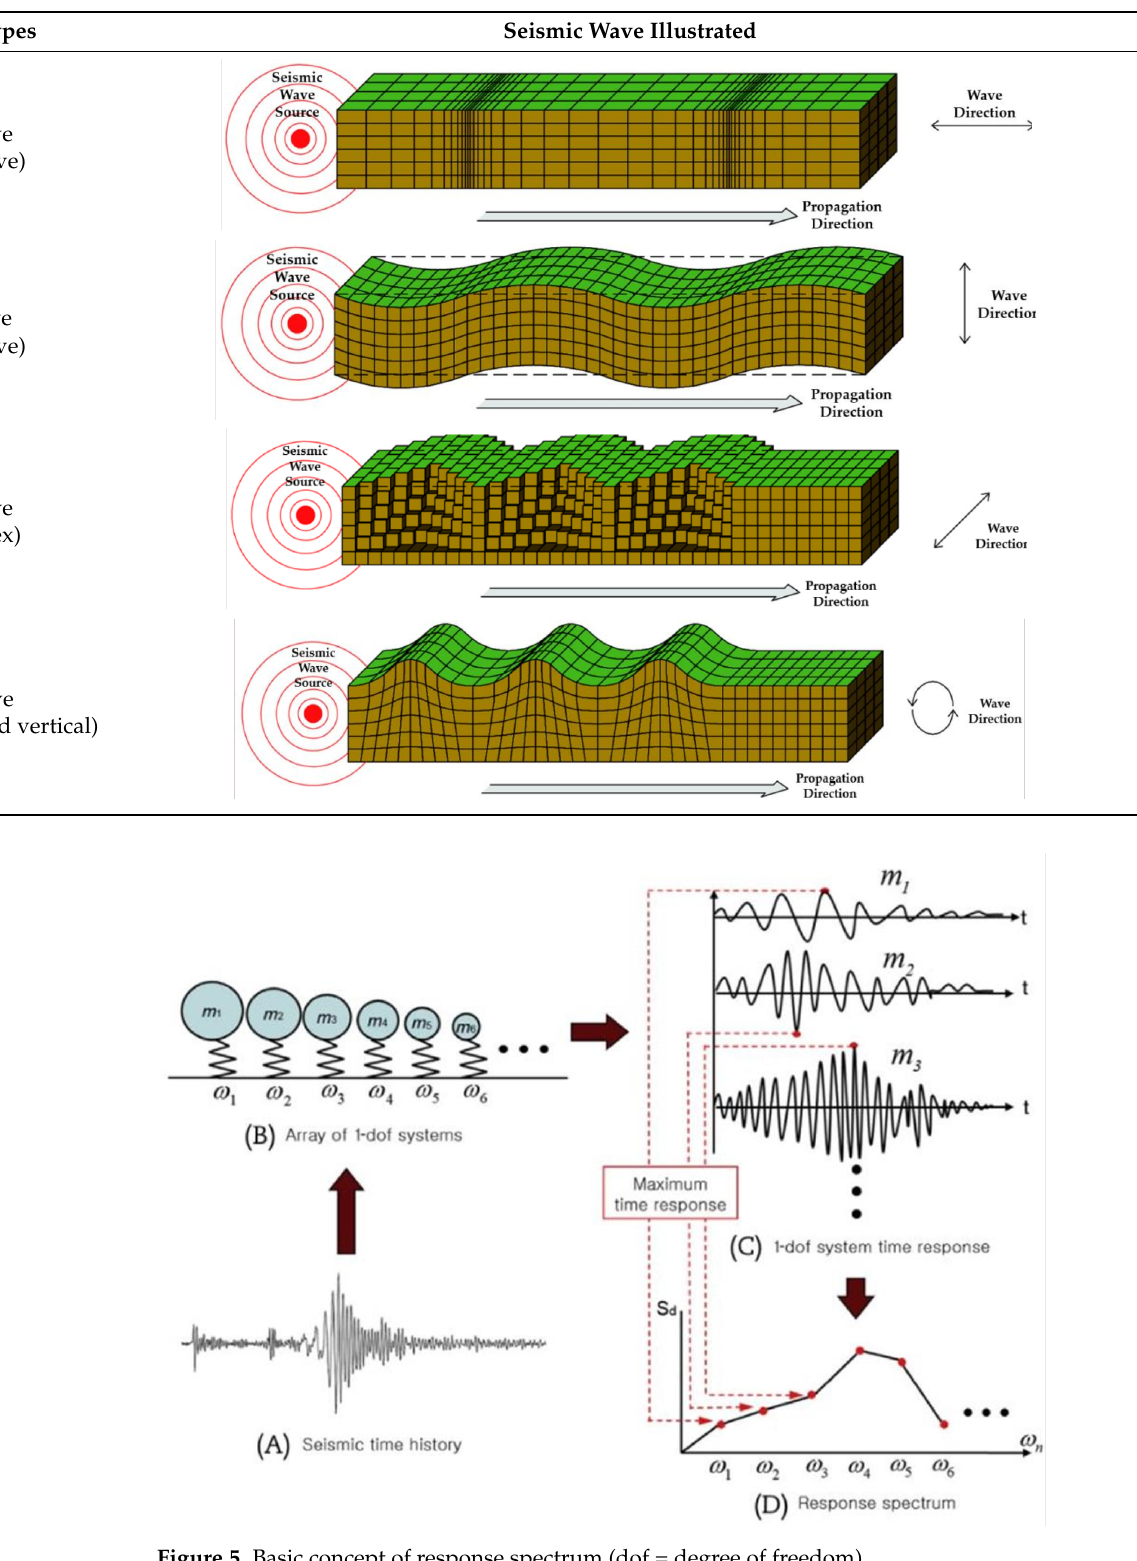
Figure 5. Basic concept of response spectrum (dof = degree of